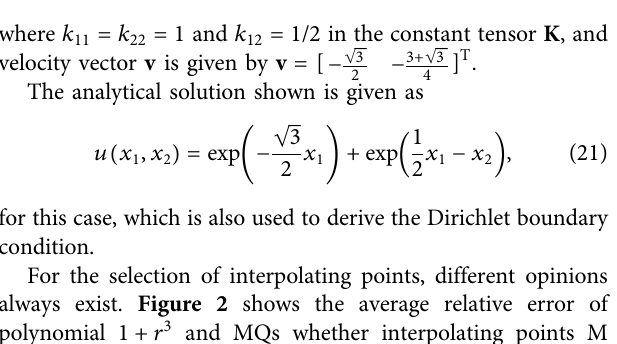
Frontiers in Physics |